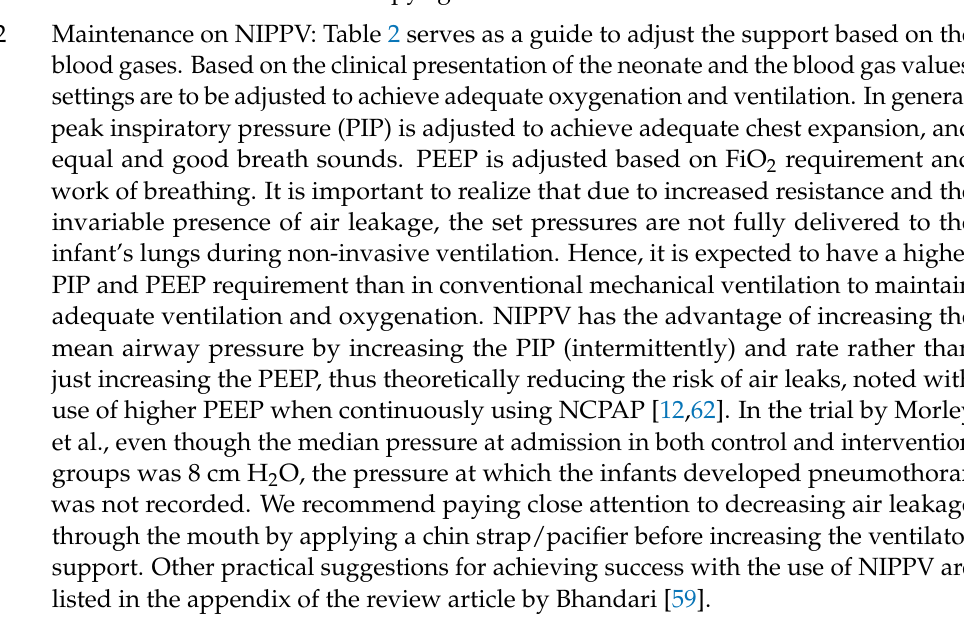
Table 2. Suggested changes in NIPPV settings based on blood